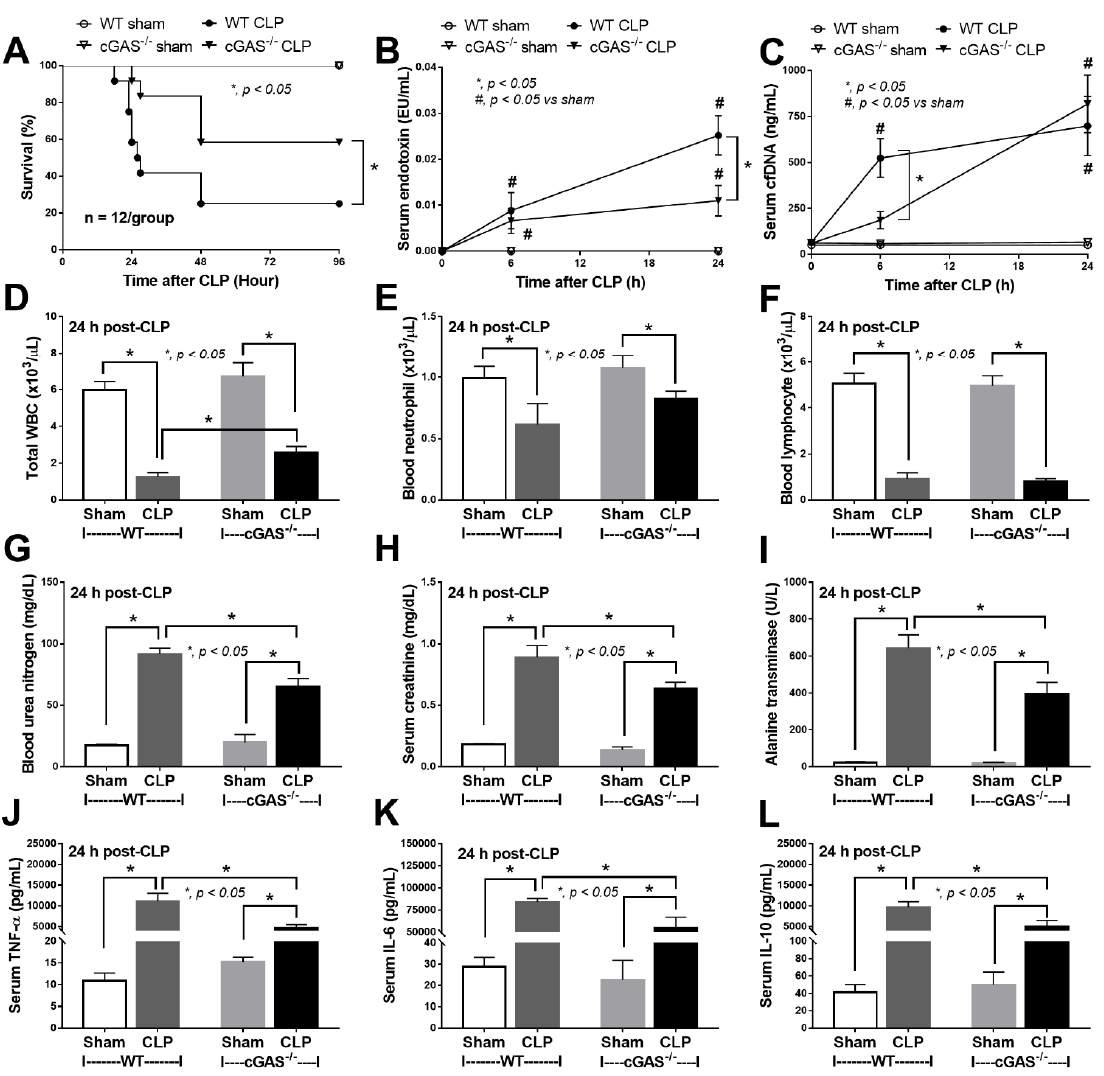
Figure 1. Characteristics of wildtype (WT) and cyclic GMP–AMP synthase deficient (cGAS -/- ) mice after sham or cecal ligation and puncture (CLP), as indicated by survival analysis ( A ), serum endotoxin ( B ), cell free DNA (cfDNA) ( C ), peripheral blood leukocyte (total, neutrophils and lymphocytes) ( D – F ), renal function (blood urea nitrogen and serum creatinine) ( G , H ), alanine transaminase ( I ) and serum cytokines (TNF- α , IL-6 and IL-10) ( J – L ) ( n = 12/group for ( A ) and n = 7–9/time-point or group for ( B – L )).